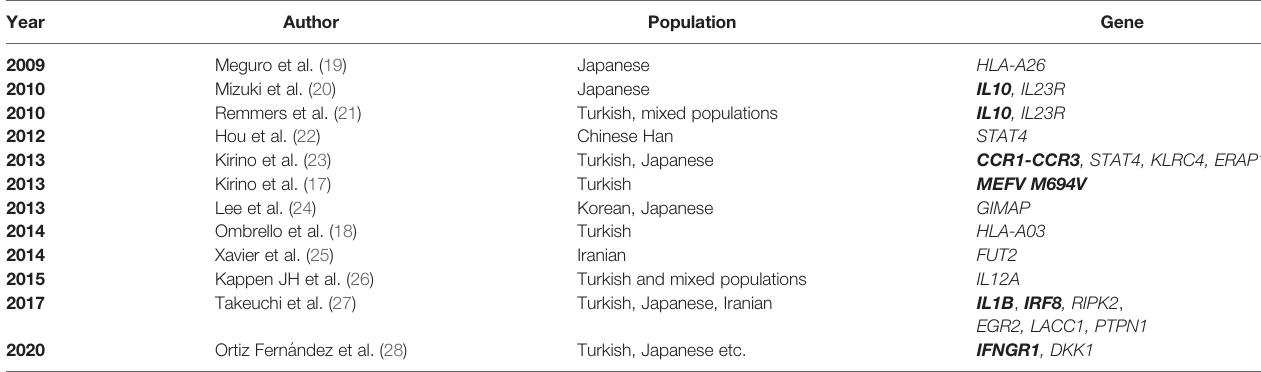
TABLE 1 | Genome-wide signi fi cant disease susceptibility loci for